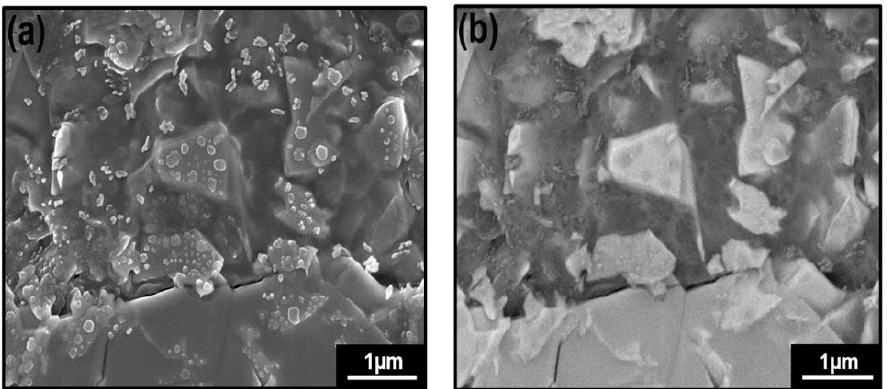
Figure 4. FESEM images of MoS 2 powder crystal after oxidation of MoS 2 by H 2 O 2 6% for 45 min: ( a ) in the secondary mode and ( b ) in the backscattering mode.